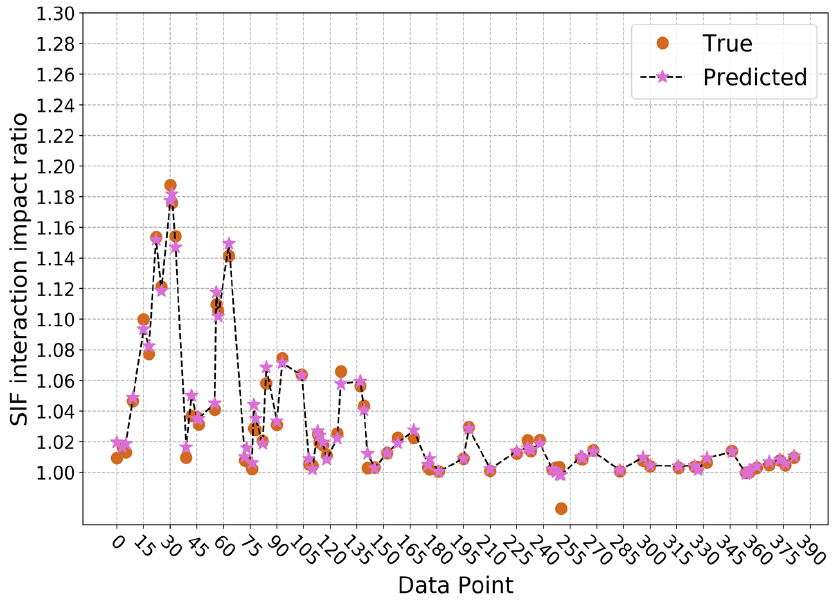
Figure 11. Prediction results of SIF interaction impact ratio based on approach 2.